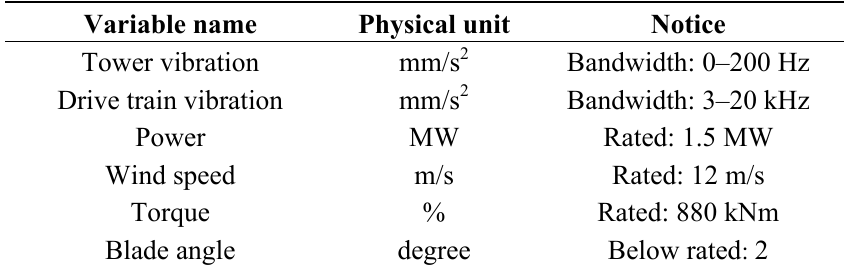
Table 1. Physical units for SCADA